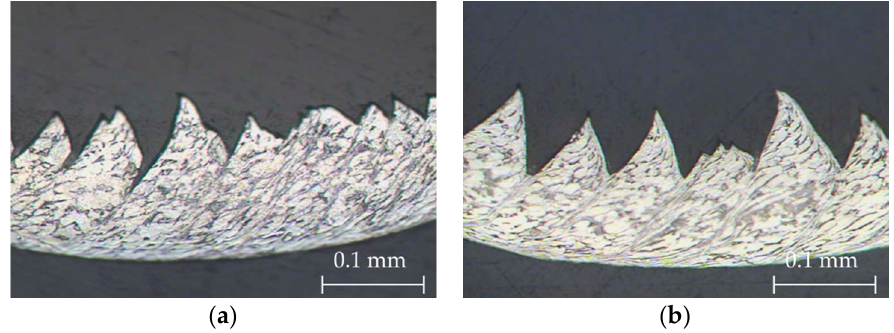
Figure 8. Chip microstructure (40×) for f = 0.10 mm/r: ( a ) v c = 30 m/min, and ( b ) v c = 125 m/min.